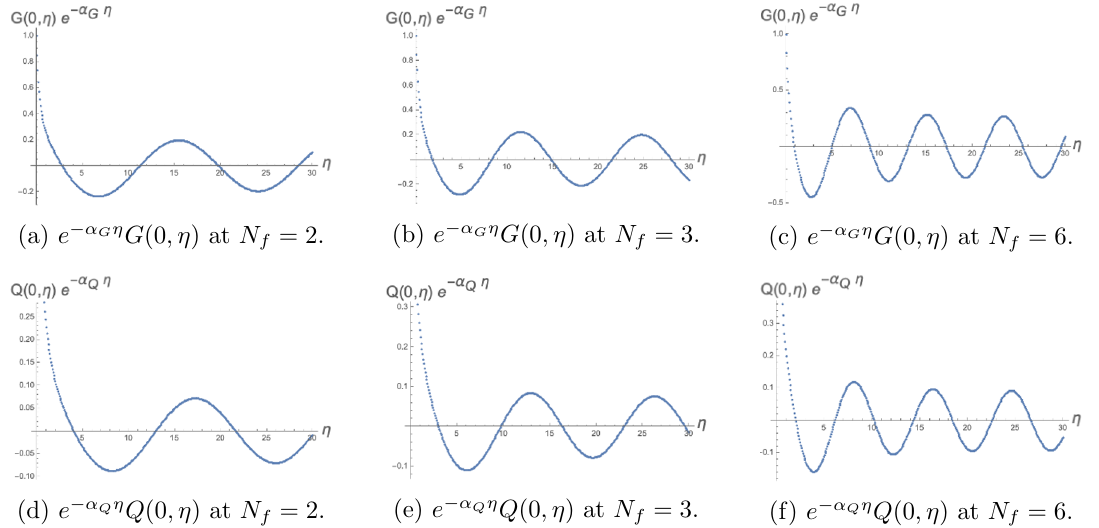
Figure 9 . Plots of e (cid:0) (cid:11) G (cid:17) G (0 ; (cid:17) ) and e (cid:0) (cid:11) Q (cid:17) Q (0 ; (cid:17) ) at N f = 2 ; 3 ; 6 and N c = 3. All the graphs are numerically computed with step size (cid:1) (cid:17) = 0 : 075 and (cid:17) max = 30.